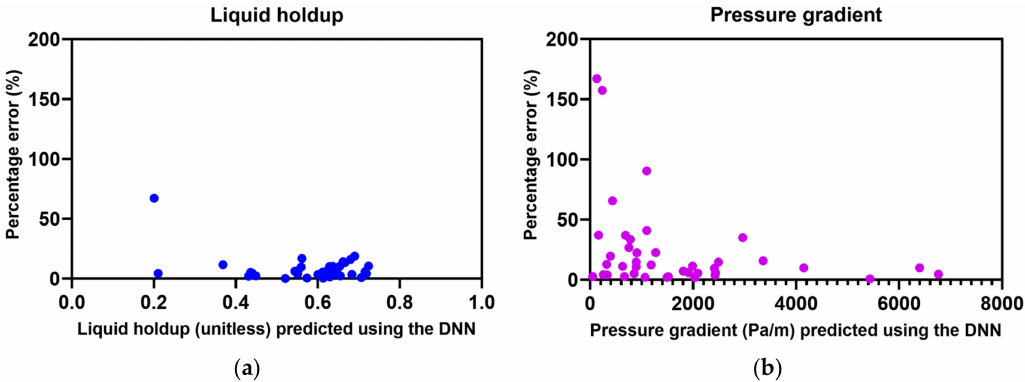
Figure 6. Scatter plot of the percentage errors using the testing dataset: ( a ) liquid holdup and ( b ) pressure